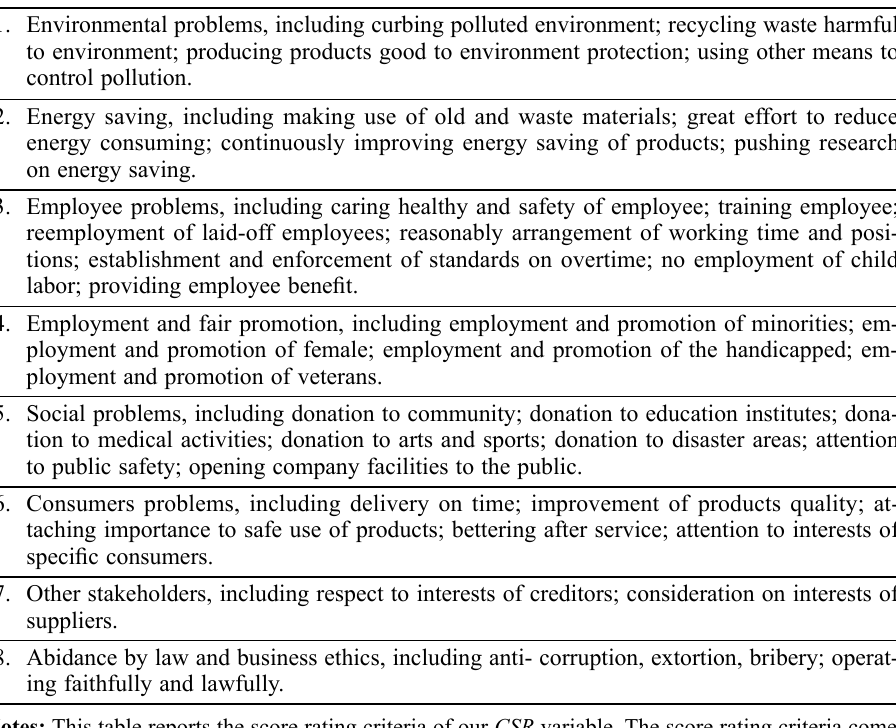
Table 1. Corporate social responsibility score rating